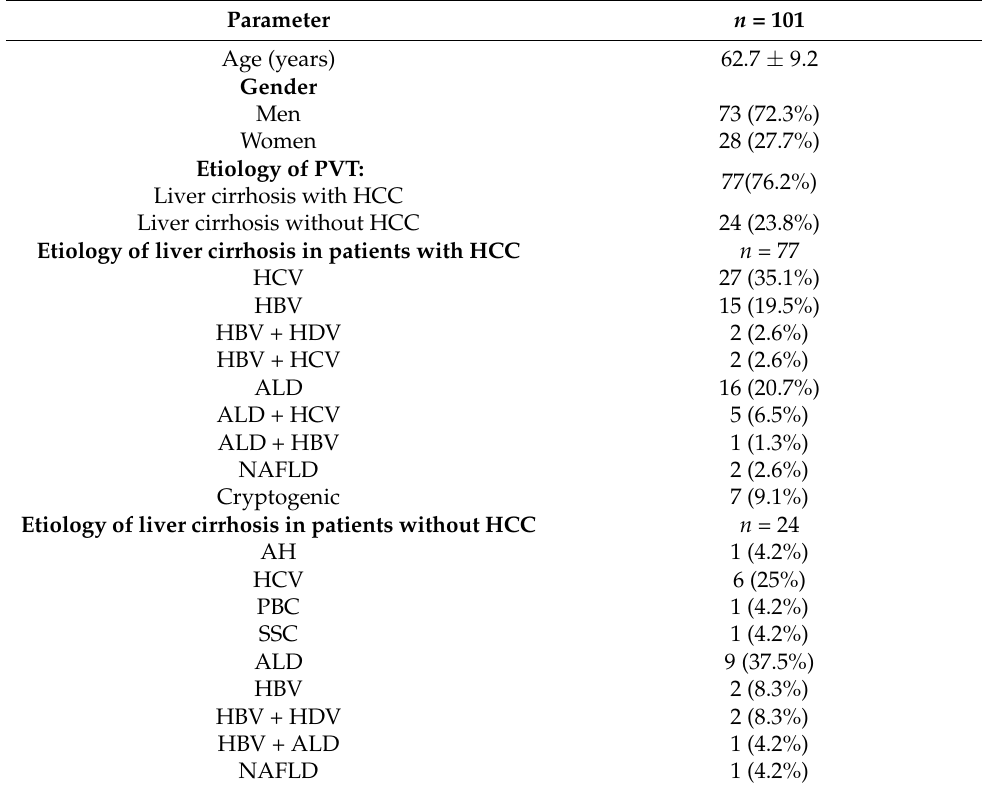
Table 1. Main characteristics of the study